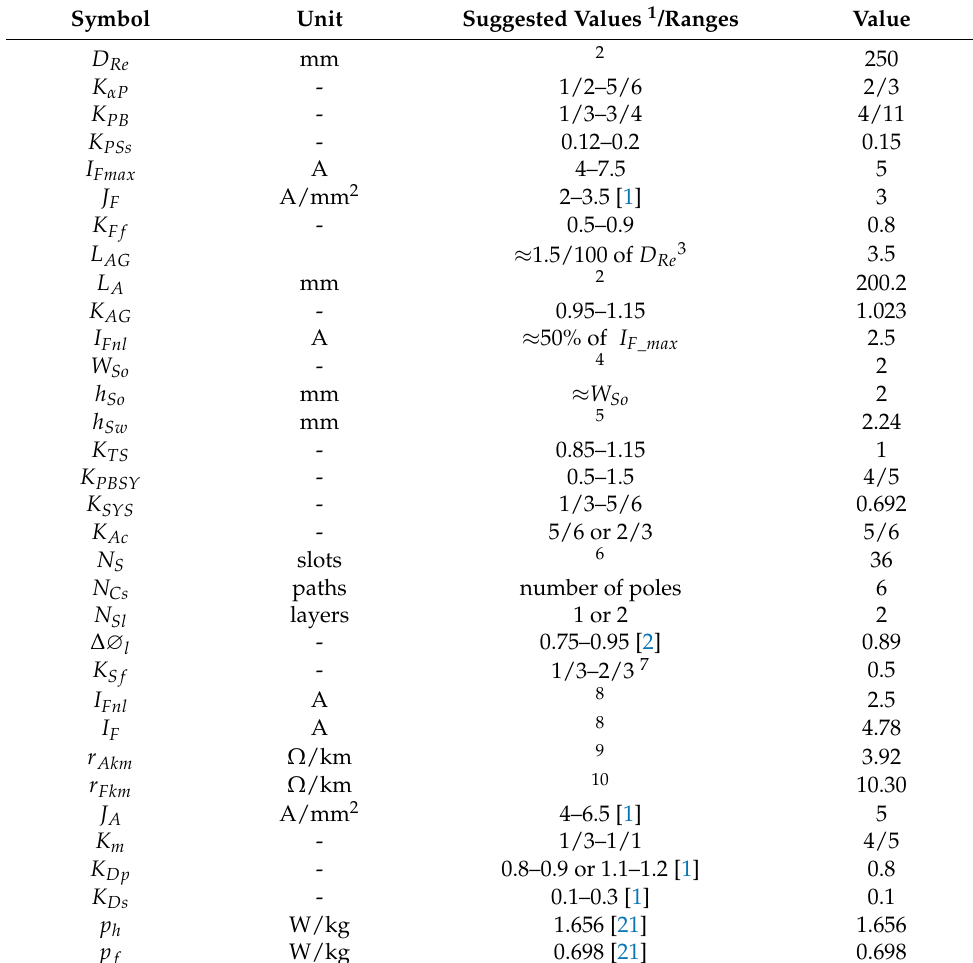
Table 2. Imposed